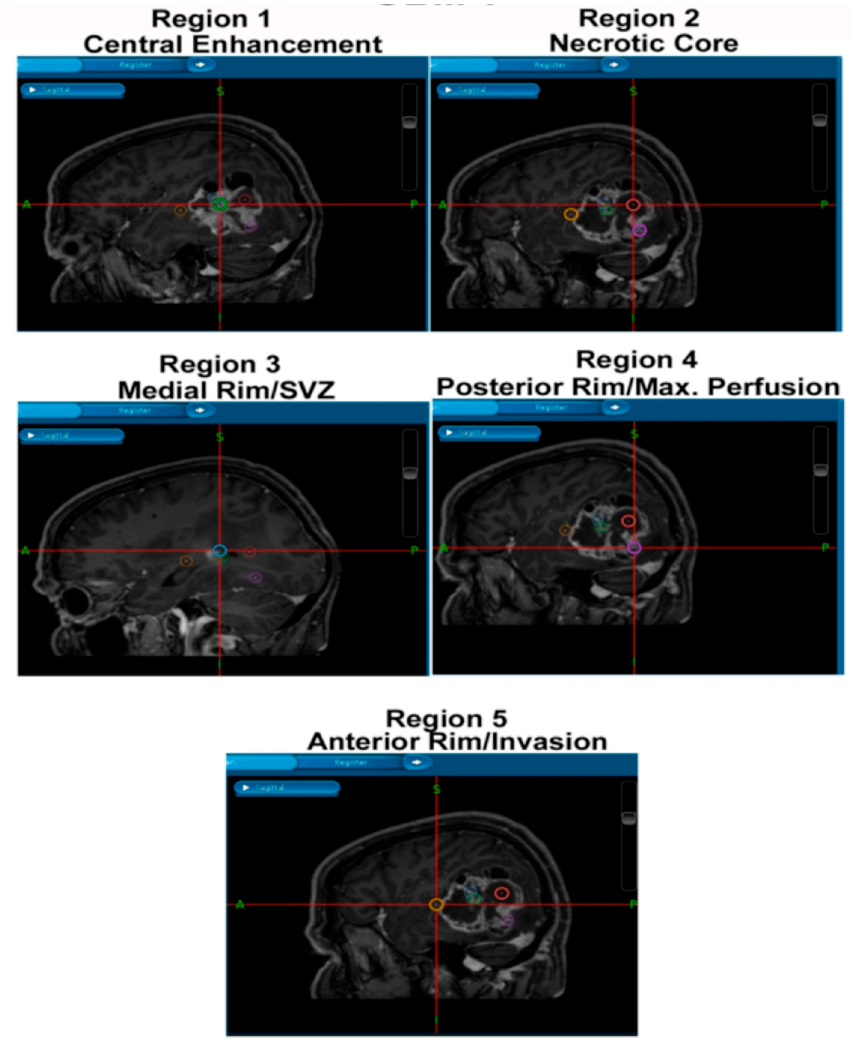
Figure 6. Multi-regional surgical sampling of primary glioblastoma multiforme (GBM). T1-weighted MRI scans of a representative patient, with cross-hairs depicting spatially-distinct multi-region surgical sampling. Regions include central enhancing core, necrotic core, medial and posterior rims and invasive margin (Region 5).